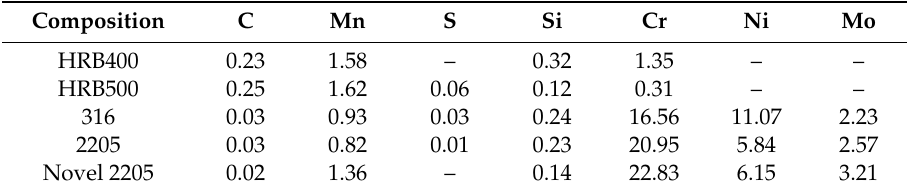
Table 1. Chemical compositions of the steels (%